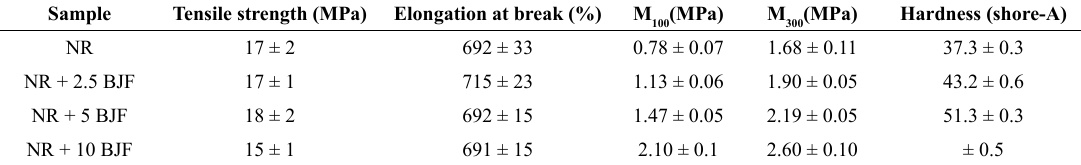
Table 3. Mechanical properties of the samples.